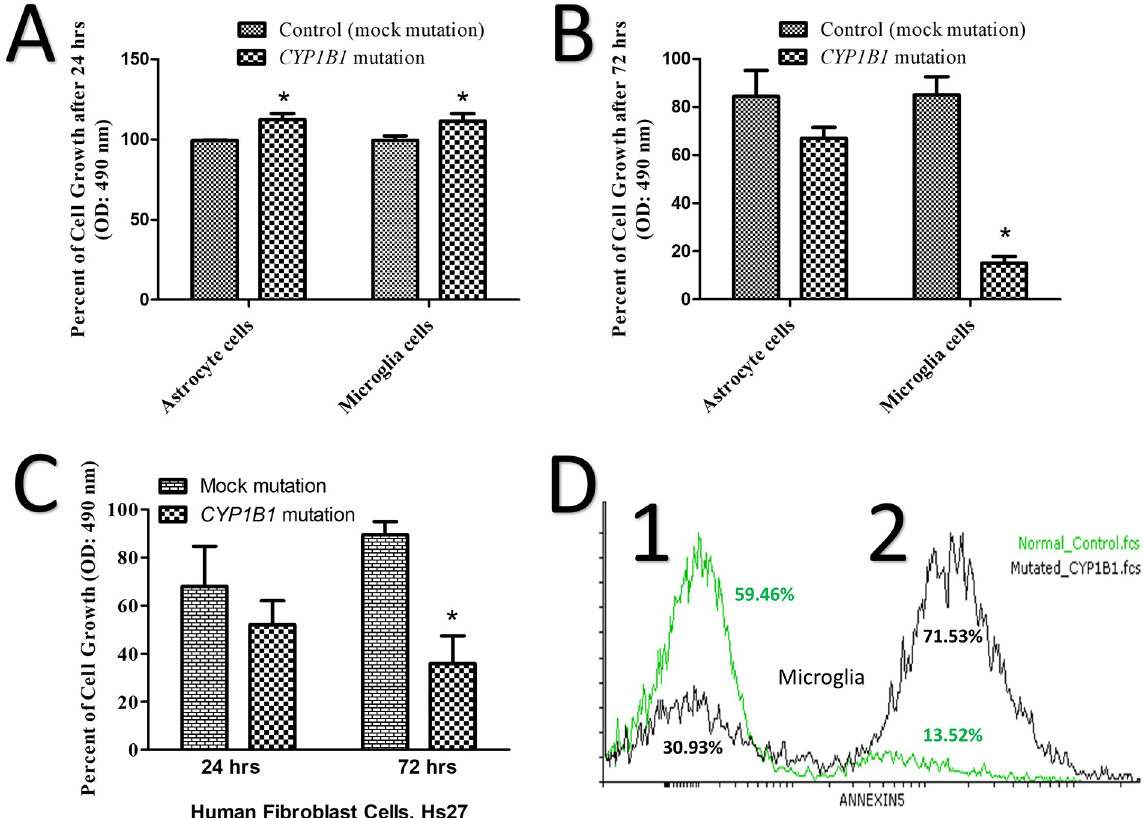
Fig 1. Mutant microglia show less cell growth and more apoptosis than the control. (A) A 10% increase in the growth of CYP1B1 mutated astrocytes and microglia after 24 hrs. (B) After 72 hrs, growth was decreased in CYP1B1 mutated microglia by 60%, but not in astrocytes. (C) The percentage of metabolic activities of the CYP1B1 mutated mesenchymal stem cells line (Hs27) after 24 hrs and 72 hrs. (D) The assessment of microglia pre-apoptosis using an annexin V assay shows 71.53% pre-apoptotic cells in the mutated cells compared to 13.52% in the healthy control. An asterisk ( � ) is displayed when the p-value was less than or equal to 0.05; the number of experimental repeats (N) was three.